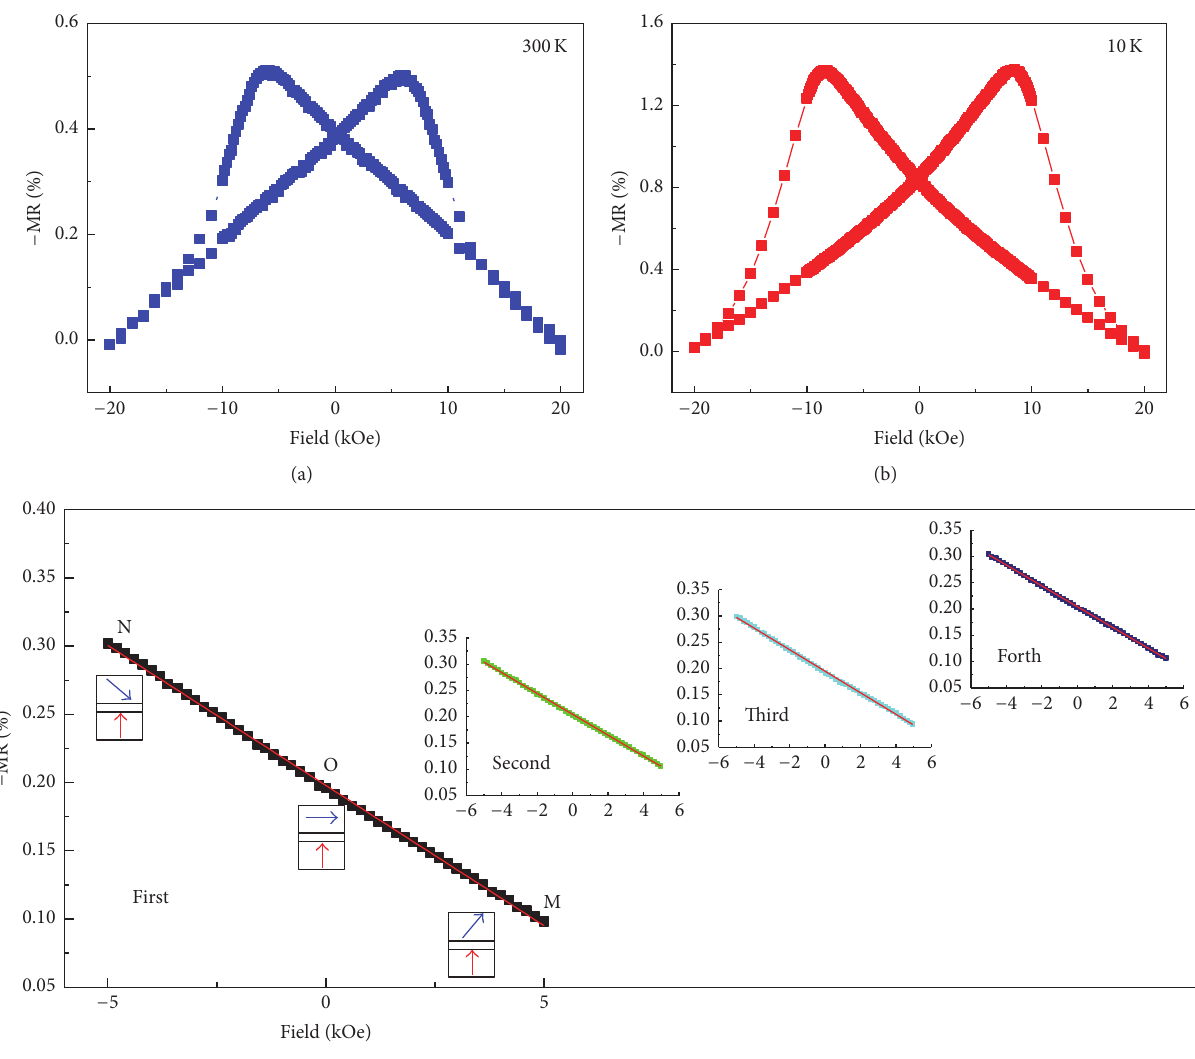
Figure 4: The MR of the multilayer films measured at 300 K (a) and 10K (b); (c) the linear magnetic field response of the multilayer films when the external field varies between +5 kOe and − 5kOe at 300 K. The insets in (c) show the three repeated measures of MR curve of the same